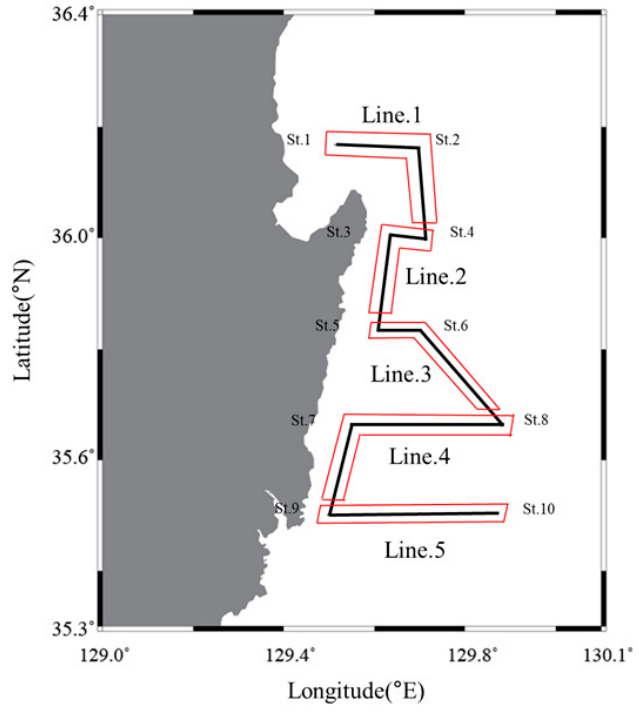
Figure 1. Survey Area.